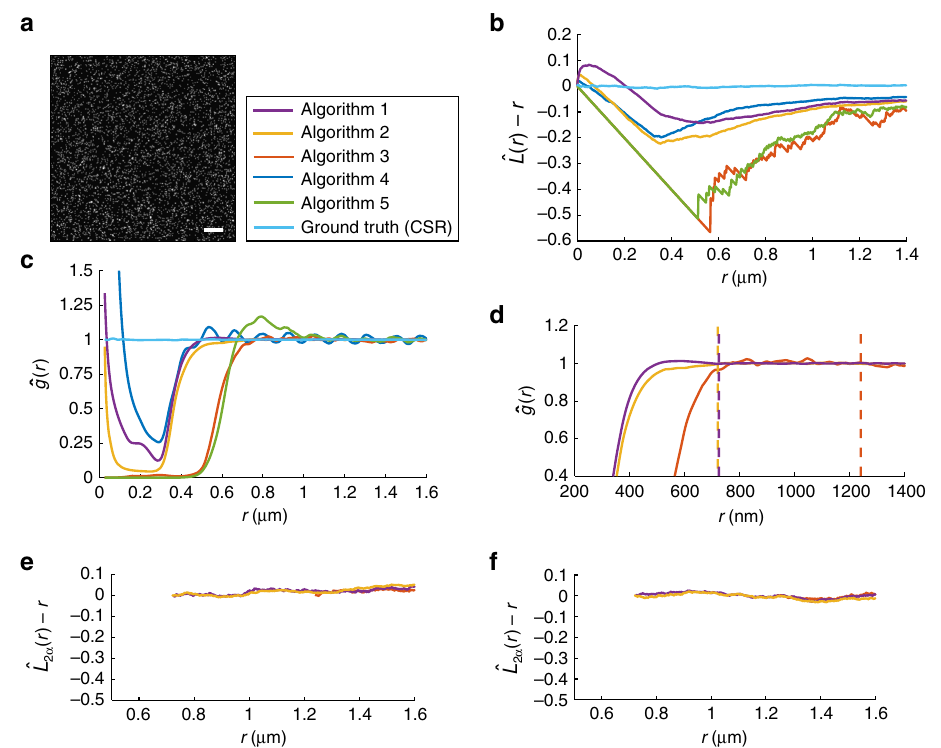
Fig. 2 Determining the algorithmic resolution limit. a A sample simulated image of the dataset analyzed to obtain the results shown in ( b ) and ( c ). Each image consists of 2500 molecules positioned at completely spatially random locations over a 50 μ m × 50 μ m region. The following numerical parameters were used to generate each image: pixel size = 13 μ m × 13 μ m, magni fi cation = 100, numerical aperture = 1.3, wavelength = 525 nm. Each molecule was simulated using an Airy pro fi le with a total of 1000 photons. Scale bar = 5 μ m. b ^ L ð r Þ (cid:2) r plots calculated based on localizations obtained from various image analysis approaches applied to ( a ) exhibit different behaviors indicating different resolving capabilities. c Pair-correlations calculated based on the localizations obtained using the image analysis approaches shown in ( b ) applied to a dataset containing 2000 images generated similar to ( a ).